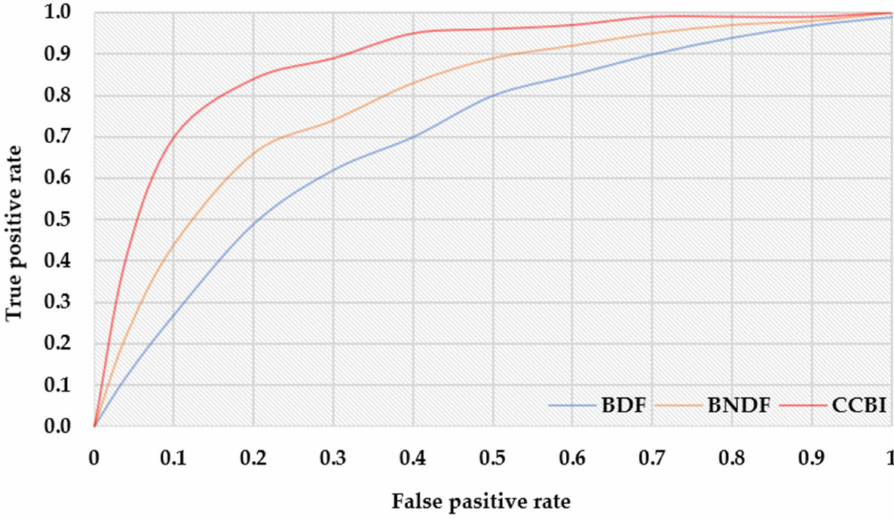
Figure 7. The result of TP and FP for three schemes.